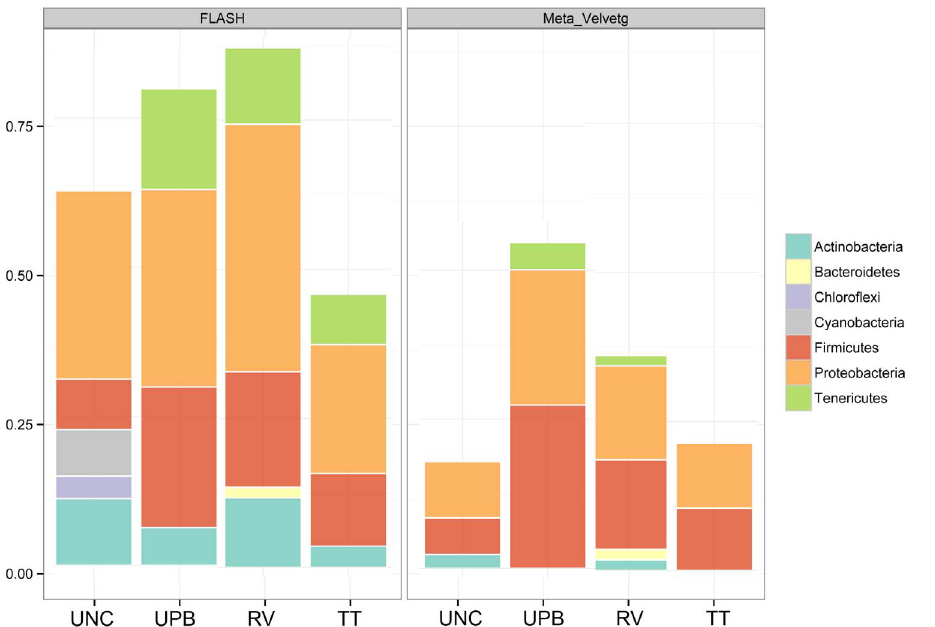
Figure 3. Taxonomic description of Phyla in uncultured and cultured samples using Flash and Meta Velvetg for assembly and the lowest common ancestor taxonomic rank of best hits (maximum e-value cutoff of 1.0 2 5 , minimum percent identity of 95%, and